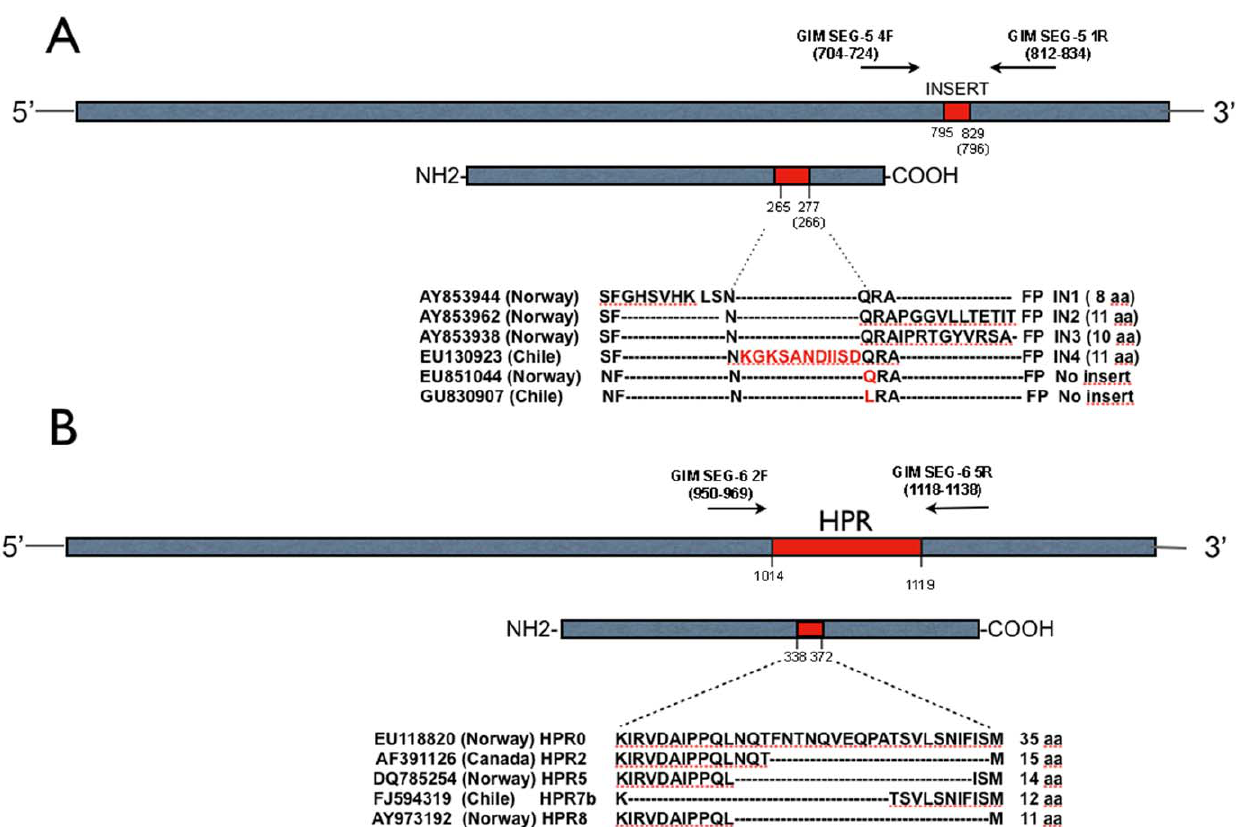
Figure 1. Primer locations for segments 5 (A) and 6 (B), respectively, relating nucleotide and amino acid positions against reference Norwegian and Chilean isolates. Nucleotide and amino acid number position under the scheme is based on sequences EU130923 (EU851044) for segment 5 and EU118820 for segment 6.